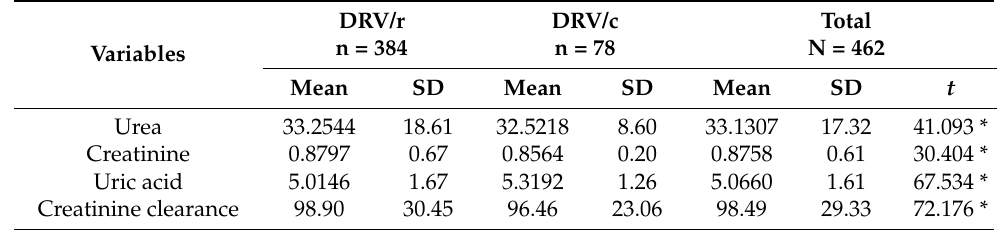
Table 11. Descriptive statistics of renal